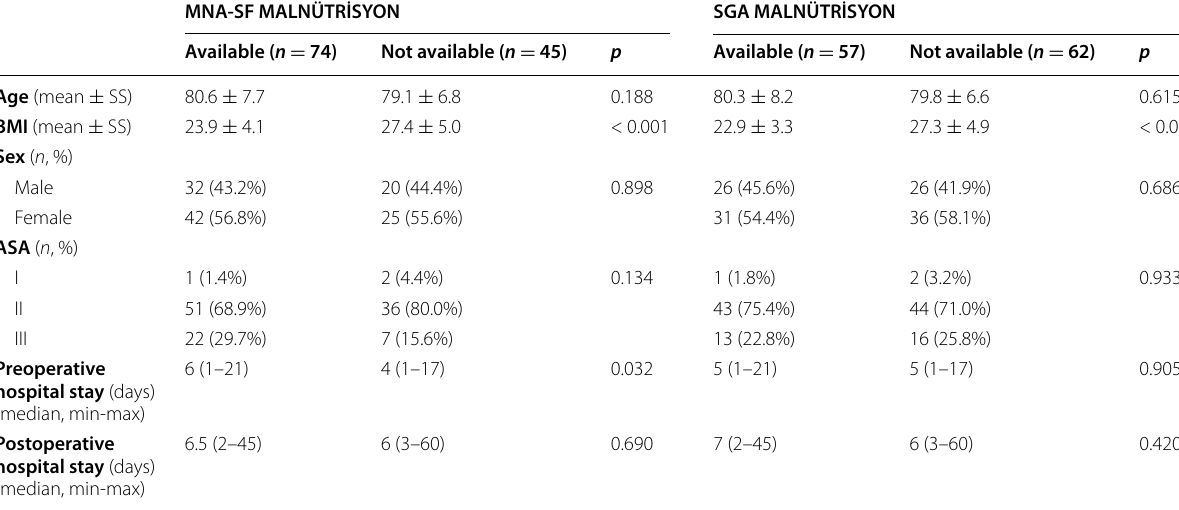
Table 2 Patients characteristics and malnutrition screening tests